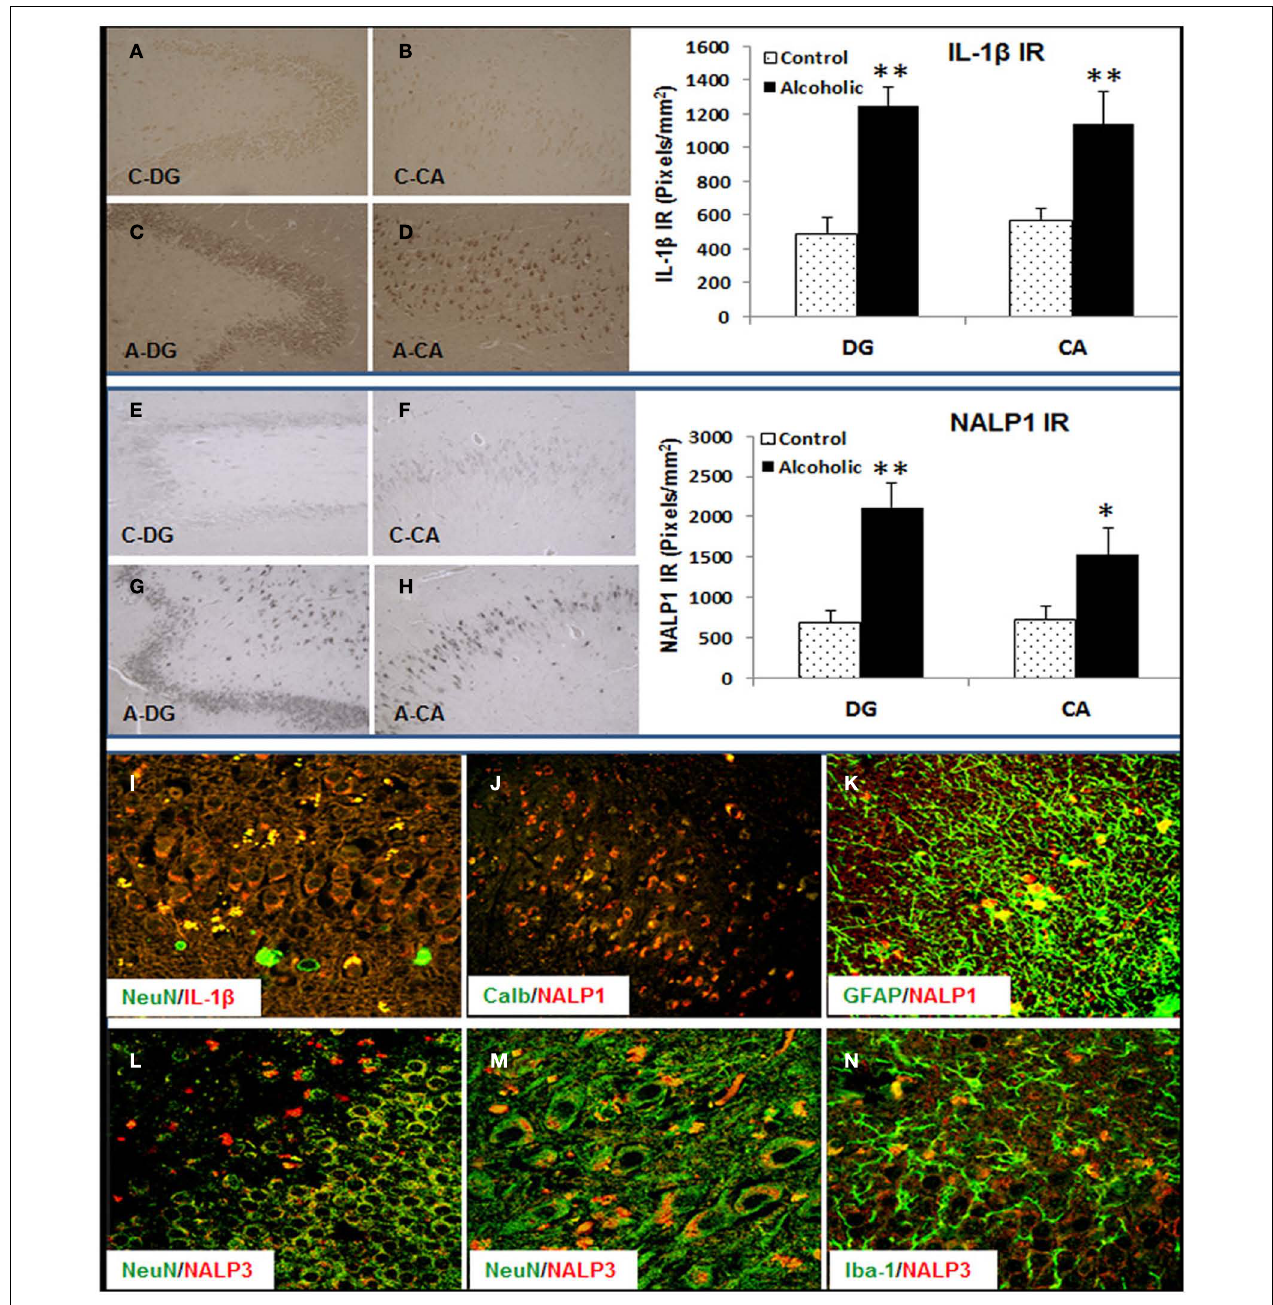
DG: ANOVA F (1,18) = 18.35, p = 0.0004, and Fisher post hoc : ** p < 0.001 compared with Controls, n = 10; CA: ANOVA F (1,18) = 4.7, p = 0.044, and Fisher post hoc : * p < 0.04 compared with Controls, n = 10. Representative images of NALP1 + IR are shown: (E) DG-Control, (F) CA-Control, (G) DG-Alcoholic, and (H) CA-Alcoholic. Bottom panel: confocal images of double fluorescent immunostaining show (I) NeuN (green) and IL-1 β (red) from DG in alcoholic (original magnification 80 × ); (J) Calbindin (Calb, green) and NALP1 (red) from CA region of hippocampus in alcoholic (original magnification 20 × ); (K) GFAP (green) and NALP1 (red) from hippocampal DG of alcoholic (original magnification 80 × ); (L–N) NeuN (green) and NALP3 (red) from hippocampal DG (L) and CA (M) of alcoholic [original magnification 80 × in (D) and 120 × in (E) ] and (N) microglial marker Iba-1 (green) and NALP3 (red) from hippocampal DG of alcoholic (original magnification 80 ×